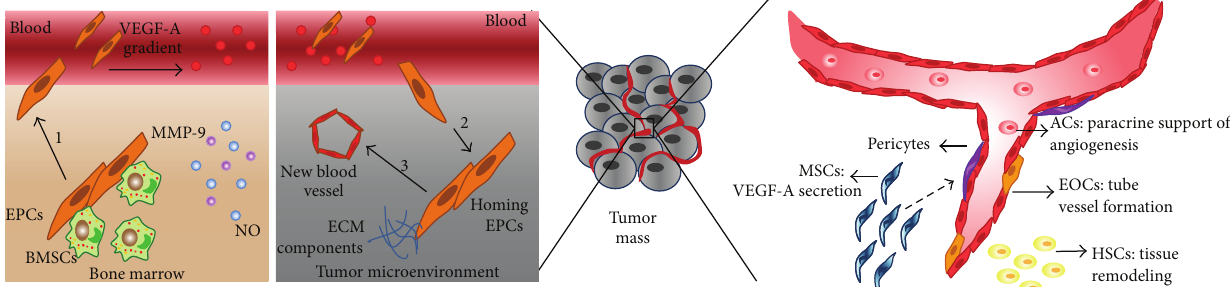
Figure2:EPCsarethemajorplayersinnewvesselformationcontributingtotumorgrowthandmetastasis.Theymightberecruitedfrombone marrow and migrate to the tumor (on the left) or either reside within tumor stroma, where there are other stem/progenitor cells that promote and/or contribute to new vessel formation (on the right: ACs: angiogenic cells; BMSCs: bone marrow-derived stem cells; ECM: extracellular matrix; EOCs: endothelial outgrowth cells; EPCs: endothelial progenitor cells; HSCs: hematopoietic stem cells; MMP: metalloproteinase; MSCs:mesenchymal stem cells; NO: nitricoxide; VEGF: vascular endothelial growth factor). Figureadapted fromMelero-Martinand Dudley [30] (license number